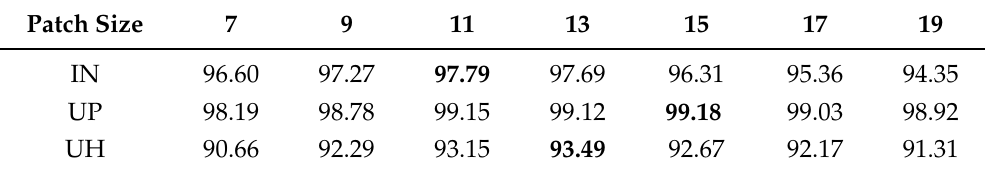
Table 7. OAs (%) of DMuCA network with different size of input patches. The best results are highlighted in bold